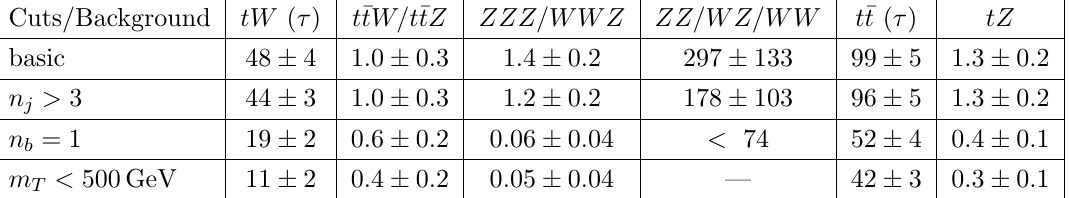
Table 7 . Event yields after each cut for the dominant backgrounds, in the analysis for t ! Sq; S ! (cid:28) + (cid:28) (cid:0) . The Z + jets sample is reduced to negligible values after the (cid:12)fth cut. The event yields presented assume a collected luminosity of L = 150 fb (cid:0) 1 .